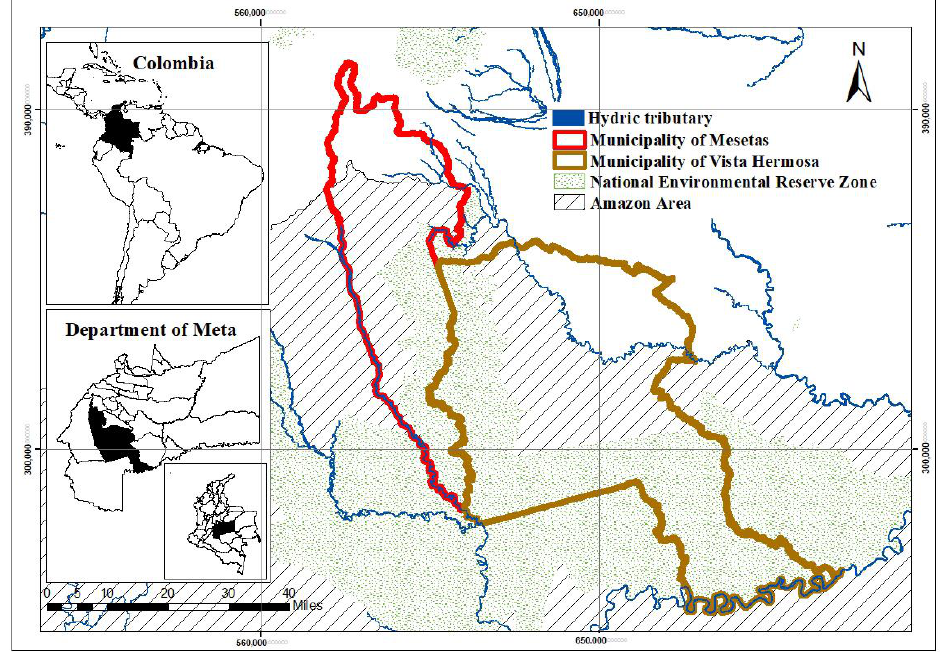
Figure 1. Spatial distribution of cocoa quality study area.